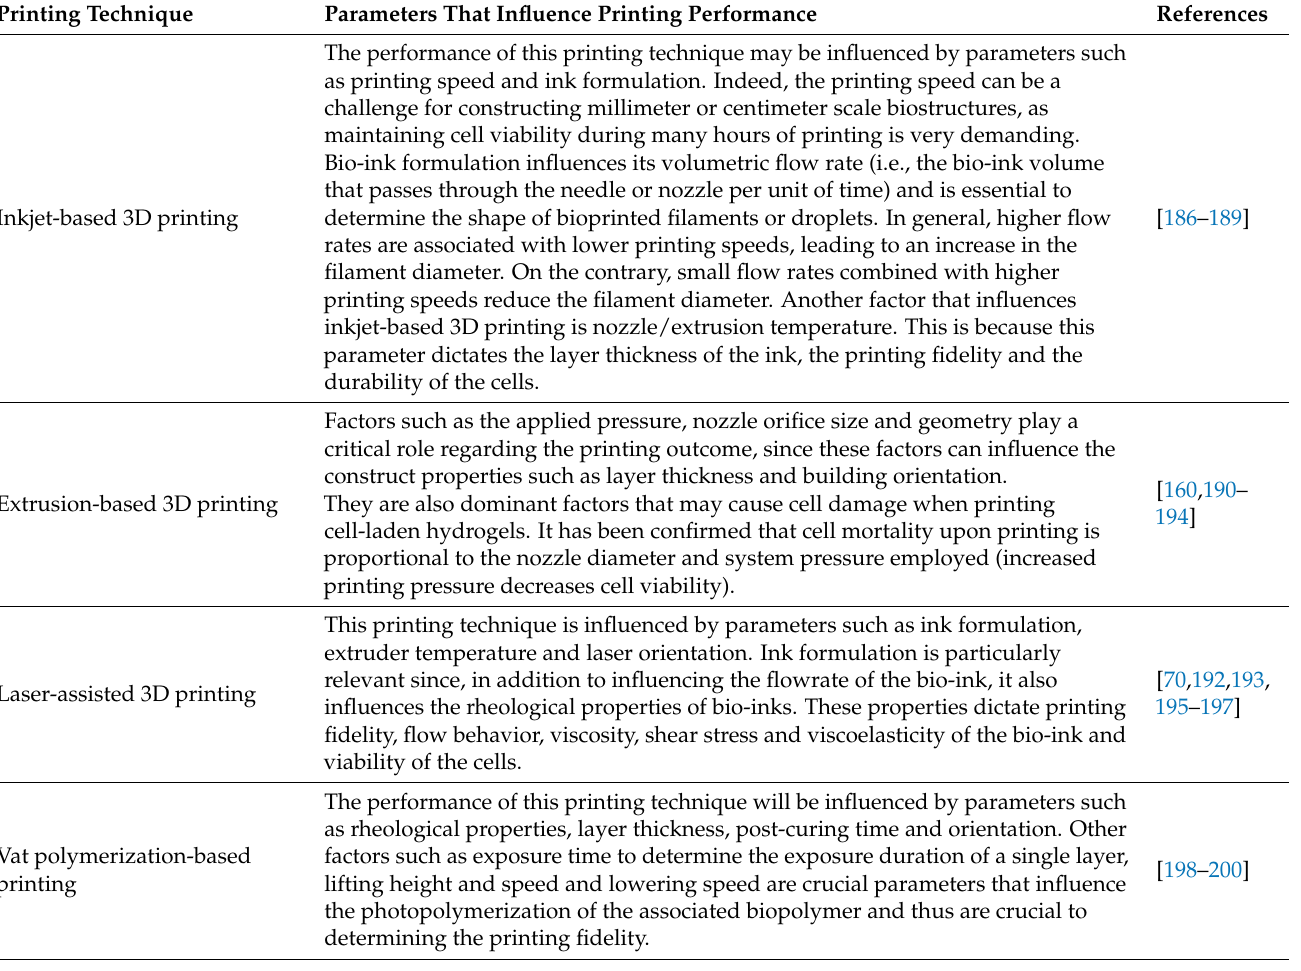
Table 3. Major parameters that influence the performances of different bioprinting